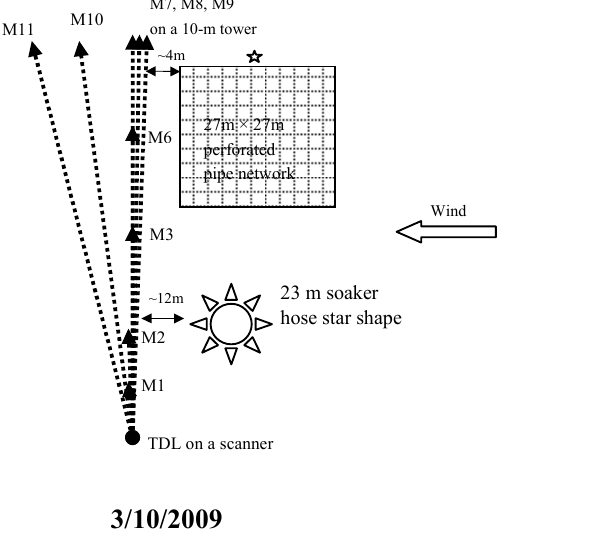
Figure 2. Layout for double emission source experiments ( : 3D sonic